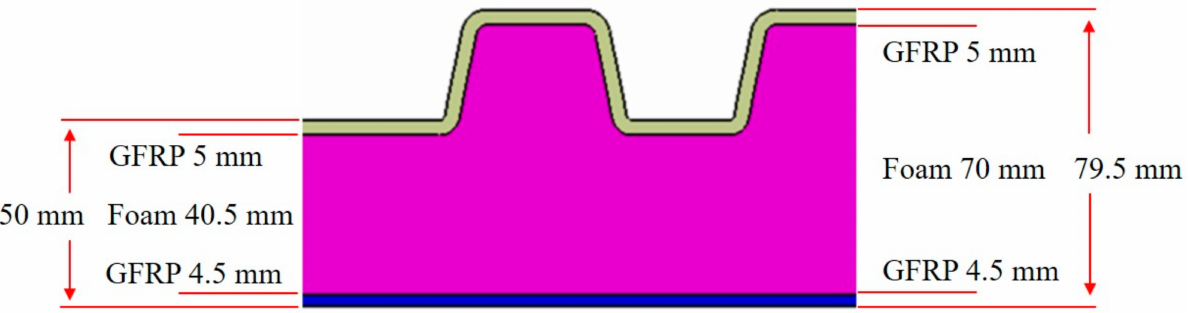
Figure 8. Dimension of floor